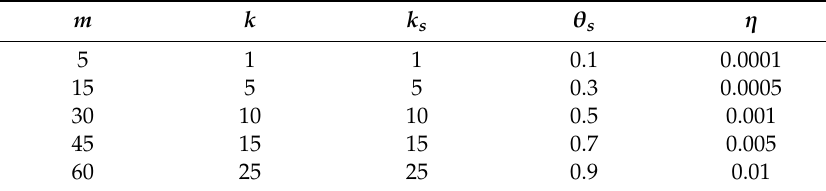
Table 6. Factors and levels of F1.